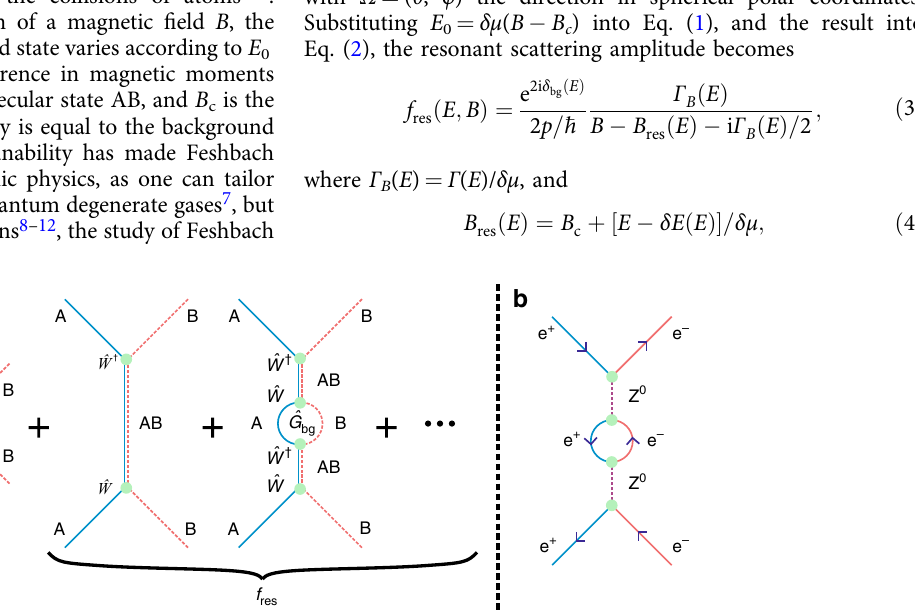
Fig. 1 Feynman diagrams for resonant collisions. a The total scattering amplitude f ( E ) for asymptotically free particles A and B is the sum of the background contribution f bg and the resonant contribution f res . The lowest order contribution to f res has A and B forming the quasi-bound state AB which then decays back to the individual particles. The next order adds a self-energy correction to the bound state energy. AB decays into particles A and B which reform into the quasi-bound state AB. b Analogous self-energy correction for the mass of the Z 0 boson in the elastic scattering of electrons and